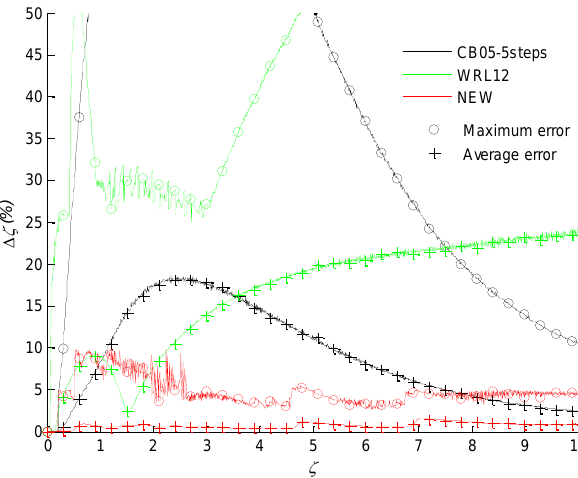
Fig. 5. Steps needed to converge into 5% relative error with CB05 equations under certain z 0 and z 0 h conditions.The inset shows the whole perspective.